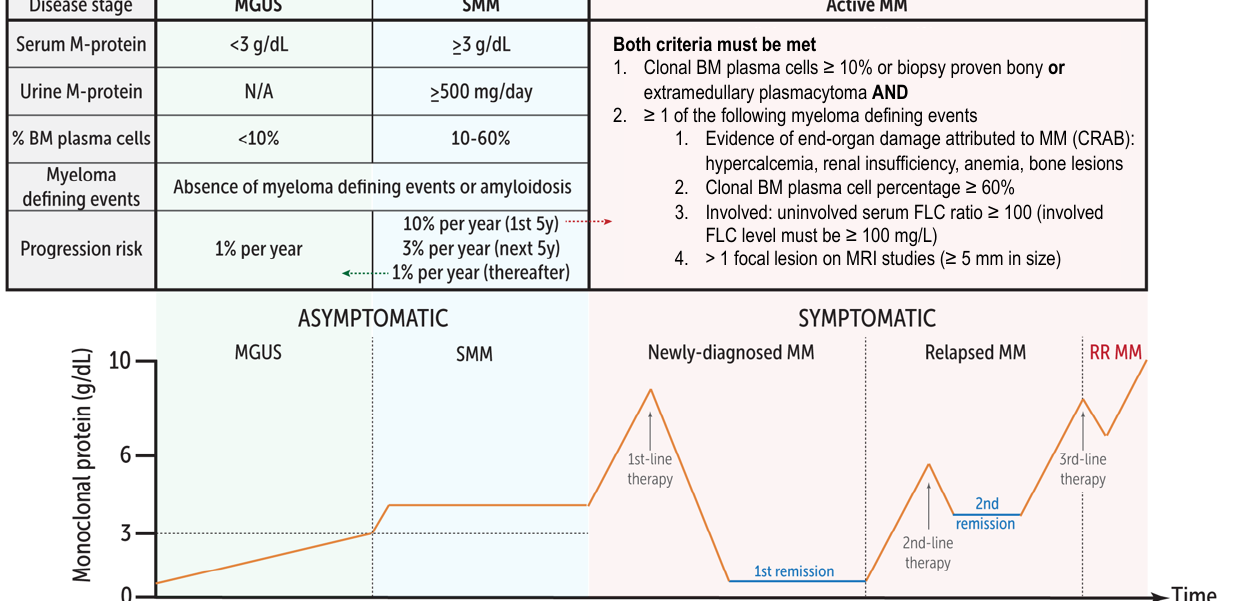
Figure 1. Multiple myeloma and asymptomatic precursor states. MM is preceded in virtually all cases by the asymptomatic precursor states monoclonal gammopathy of undetermined significance (MGUS) and smoldering multiple myeloma (SMM). The international myeloma working group (IMWG) defines asymptomatic MM as having ≥ 1 myeloma defining events with either clonal BM plasma cells ≥ 10% or biopsy proven plasmacytoma.